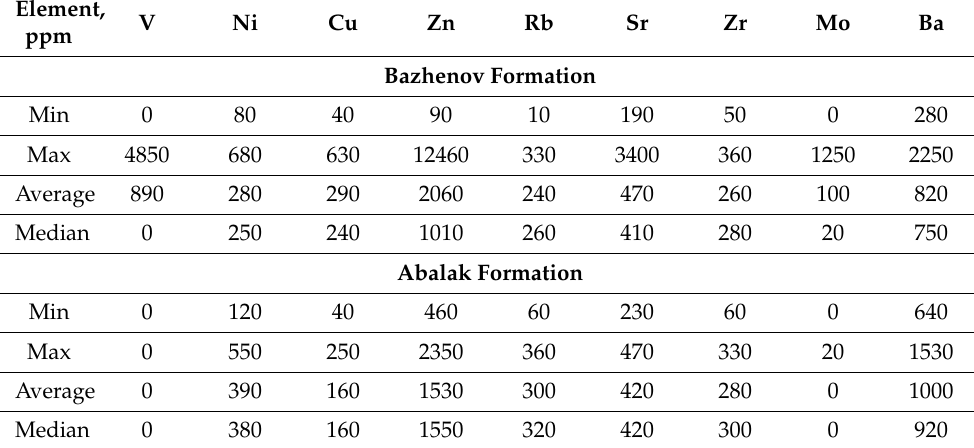
Table A2. Summary of trace element composition measured by portable XRF-spectrometer.